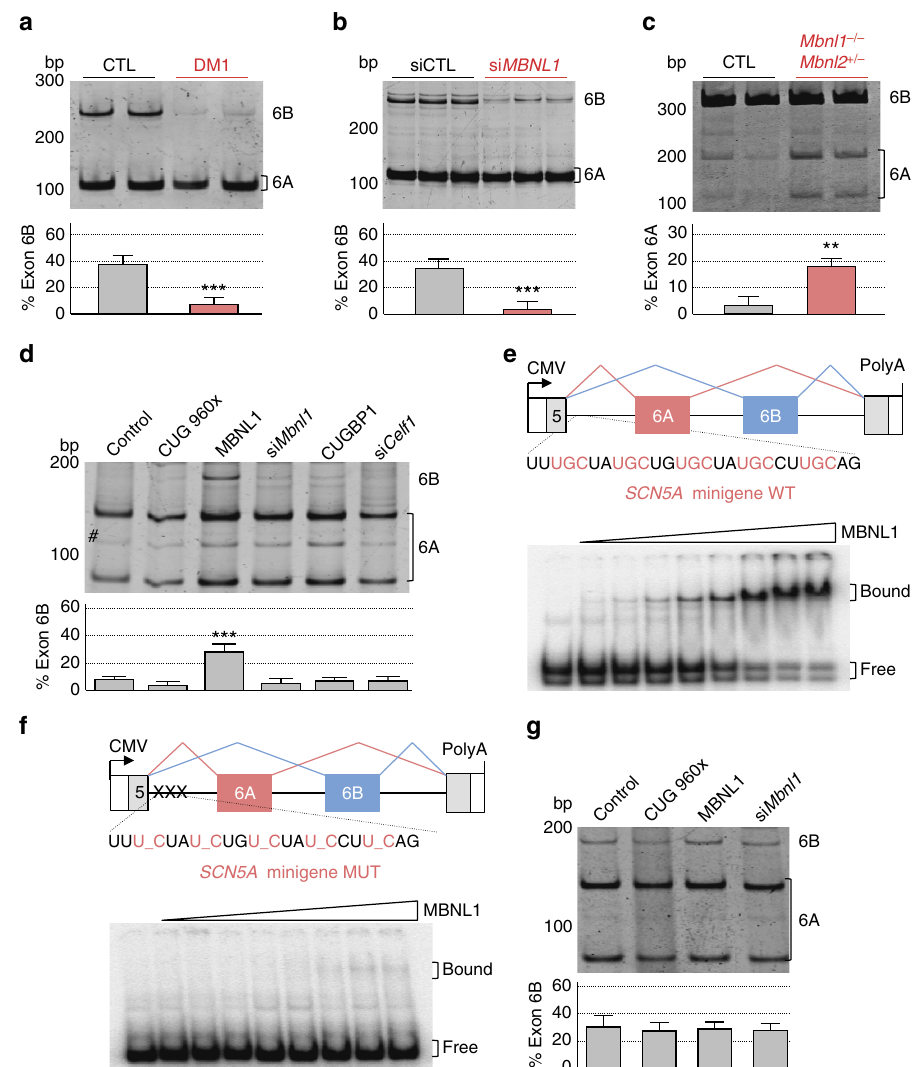
Figure 4 | MBNL1 regulates alternative splicing of SCN5A . ( a ) Upper panel, RT–PCR analysis of endogenous SCN5A mRNA from differentiated primary muscle cell cultures derived from biopsies of control or DM1 individuals. (lower) Quantification of the percentage of SCN5A mRNA including exon 6B. ( b , upper) RT–PCR analysis of endogenous SCN5A mRNA from human differentiated cultures of control primary muscle cells transfected with a scrambled siRNA (siCTL) or a siRNA targeting MBNL1 mRNA (si MBNL1 ). (lower) Percentage of SCN5A mRNA including exon 6B. ( c , upper) RT–PCR analysis of endogenous Scn5a mRNA in heart samples of wild-type and compound Mbnl1 (cid:2) / (cid:2) , Mbnl2 þ / (cid:2) double knockout mice. (lower) Percentage of Scn5a mRNA including exon 6A. ( d , upper) RT–PCR analysis of exogenous SCN5A mRNA from differentiated C2C12 muscle cells co-transfected with a SCN5A minigene containing exons 6A and 6B bordered by their introns and with either a plasmid expressing 960 CTG repeats, MBNL1, CUGBP1 or with a siRNA directed against Mbnl1 (si Mbnl1 ) or Celf1 (encoding Cugbp1; si Celf1 ). # Indicates usage of a cryptic splice site inherent to the minigene. (lower) Percentage of SCN5A mRNA including exon 6B. ( e , upper) Schematic representation of SCN5A minigene, including the UGC-rich sequence used for binding assays. (lower) Gel- shift assays were performed using 5–1,000nM of purified bacterial recombinant GST-MBNL1 D 101 and a uniformly 32 P-CTP labelled RNA. ( f , upper) Schematic representation of mutant SCN5A minigene, including the mutant sequence, used for binding assays. (lower) Gel-shift assay performed as in e . ( g , upper) RT–PCR analysis of exogenous SCN5A mRNA from differentiated C2C12 muscle cells co-transfected with mutant SCN5A minigene and with a plasmid expressing 960 CTG repeats or MBNL1 or with a siRNA directed against Mbnl1 (si Mbnl1 ). (lower) Percentage of SCN5A mRNA including exon 6B. All transfection and gel-shift experiments were repeated three to five times. Molecular size markers are indicated in bp. Bars indicate s.e.m. Student test, ** indicates P o 0.01, *** indicates P o 0.001. bp, base